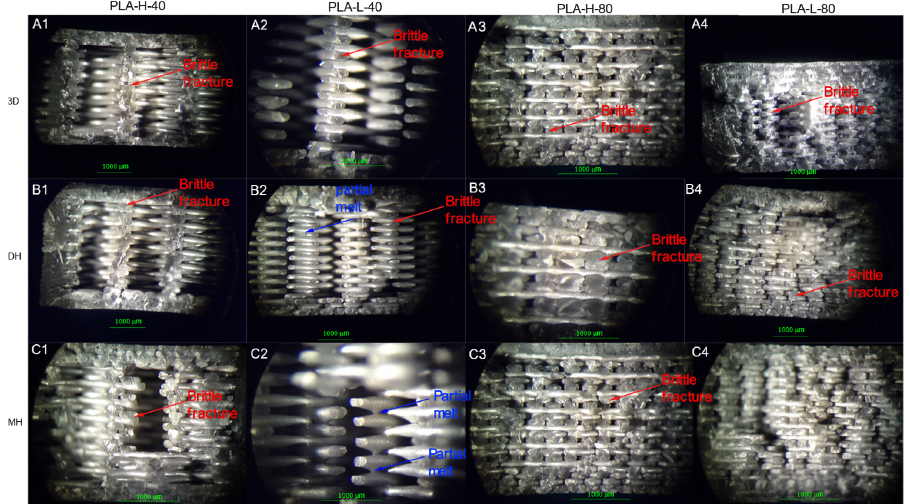
Figure 9. Optical microscope images of the fracture surface of 3the D printed PLA-based samples after the Charpy test. Control samples (without sterilization process treatment): ( A1 – A4 ) PLA-H-40, PLA-L-40 PLA-H-80 and PLA-L-80; samples after the Dry Heat (DH) sterilization process: ( B1 – B4 ) PLA-H-40, PLA-L-40, PLA-H-80 and PLA-L-80; as well as samples after the Moist Heat (MH) sterilization process: ( C1 – C4 ) PLA-H-40, PLA-L-40, PLA-H-80 and PLA-L-80.